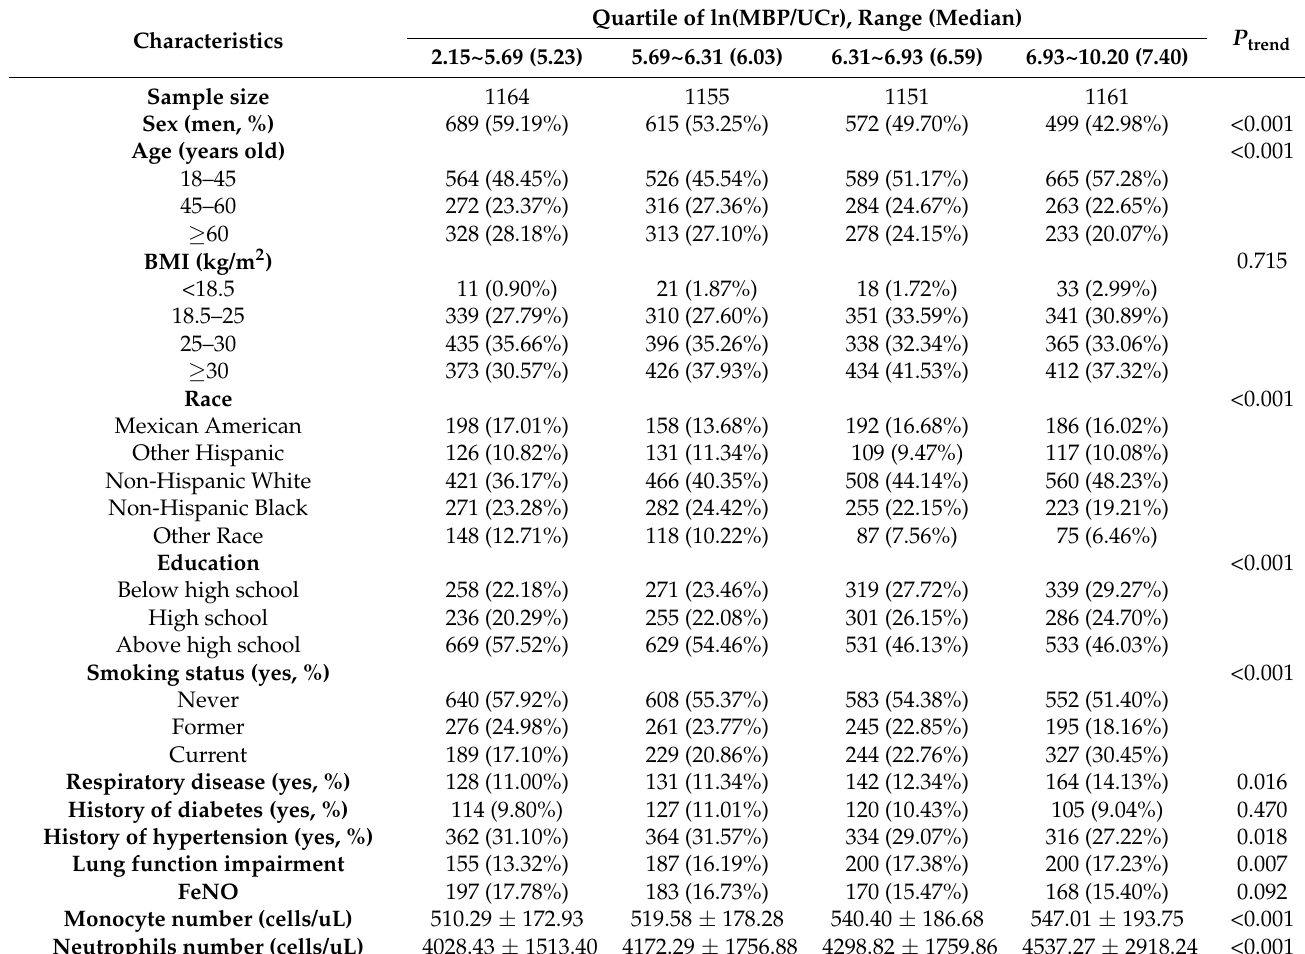
Table 2. The clinical characteristics of study population according to the concentration of urinary